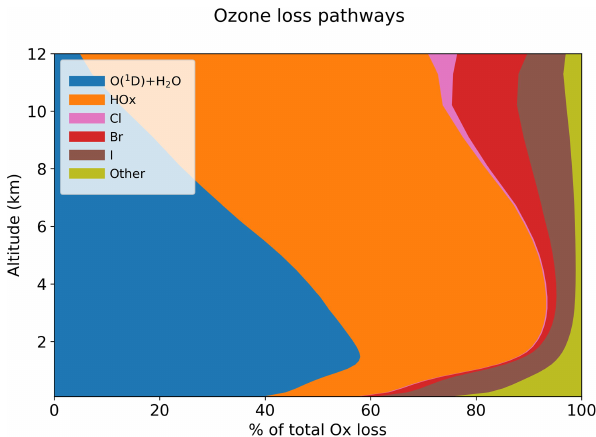
Figure 14. Contributions of different pathways to the global annual loss of tropospheric ozone as a function of altitude. The “other” pathway includes sinks from reactions with alkenes and HNO 3 de-